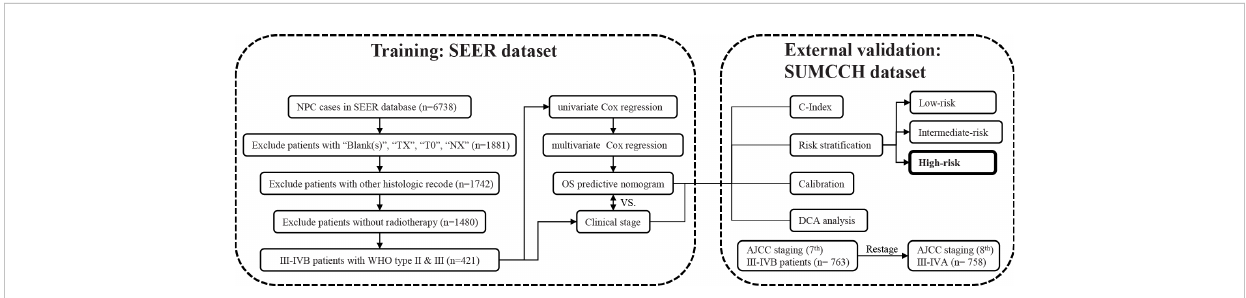
FIGURE 1 The entire analysis procedure. SEER, Surveillance, Epidemiology, and End Results; SUMCCH, Shantou University Medical College Cancer Hospital; NPC, nasopharyngeal carcinoma; WHO, World Health Organization; OS, overall survival; C-index, concordance index; DCA, decision curve